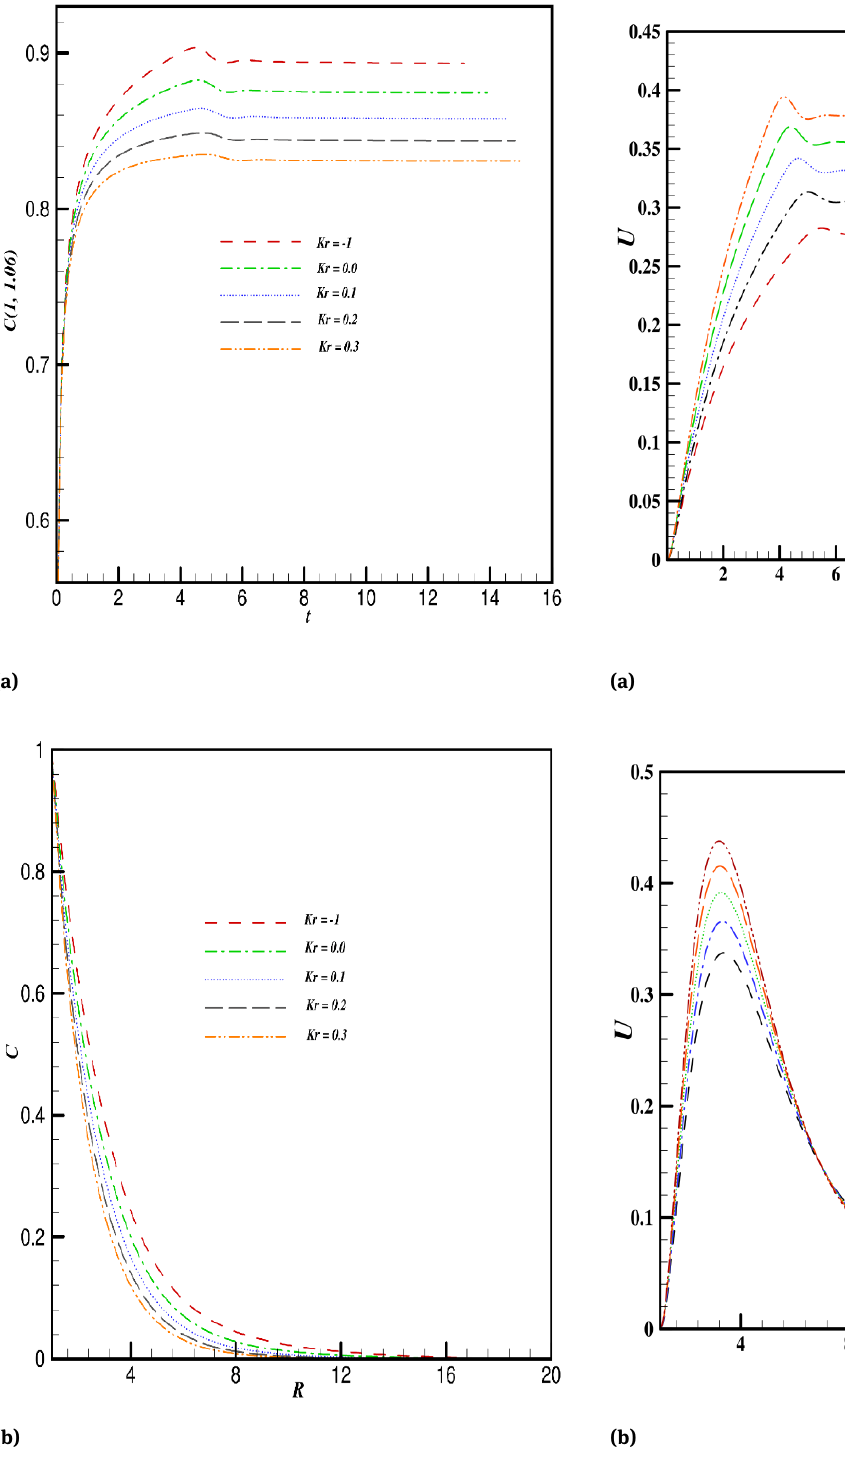
Figure 12: ( a ) Transient and ( b ) Steady state concentration profiles with fixed Sc = 0.6 , Pr = 0.7 , Bu = 1.0 , Nr = 1.0 , K 1 = 1.0 , M = 0.2 , Ec = 0.1 .